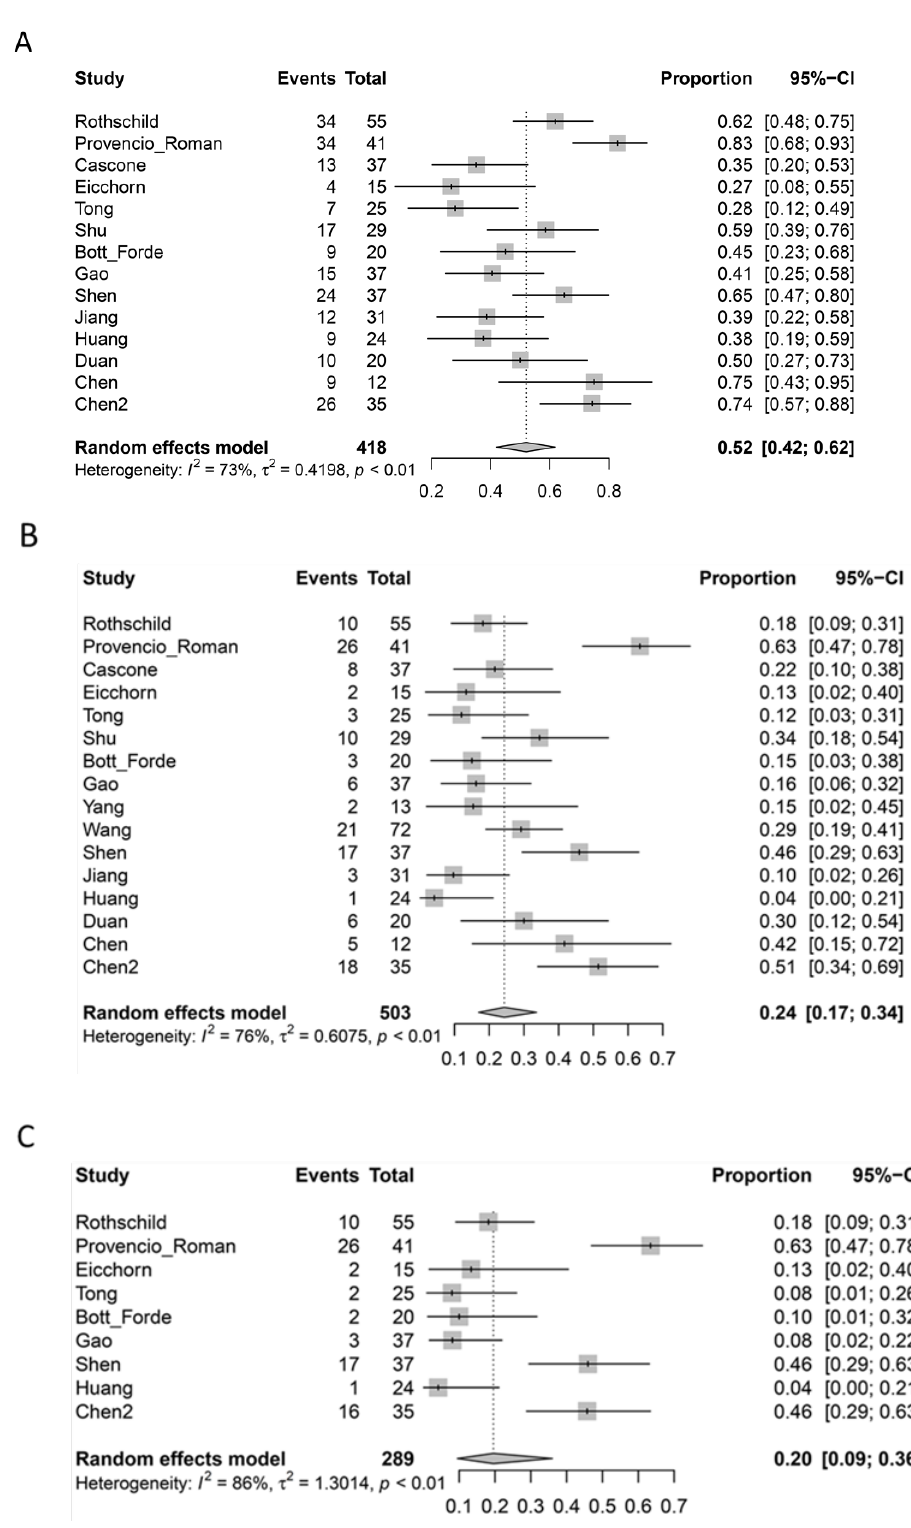
Figure 2. ( A ) Forest plot summarizing the proportion of patients with major pathological responses after neoadjuvant immunotherapy for resectable non-small cell lung cancer. ( B ) Forest plot summa- rizing the proportion of patients with complete pathological response of the primary tumor after neoadjuvant immunotherapy for resectable non-small cell lung cancer. ( C ) Forest plot summarizing the proportion of patients with complete pathological response of the primary tumor and sampled lymph nodes after neoadjuvant immunotherapy for resectable non-small cell lung cancer.